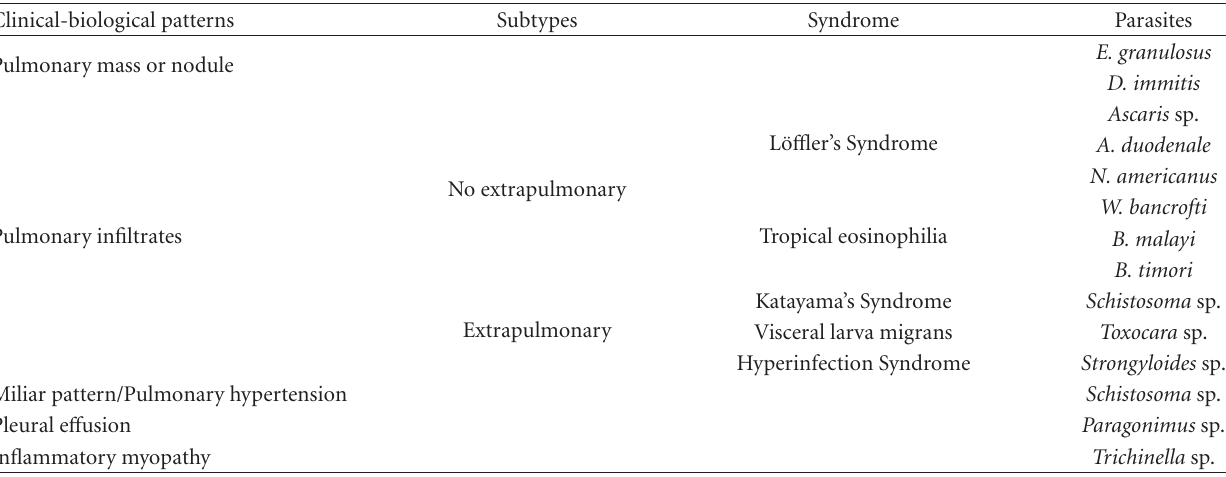
Table 1: Clinical-biological pattern in pulmonary helminthic